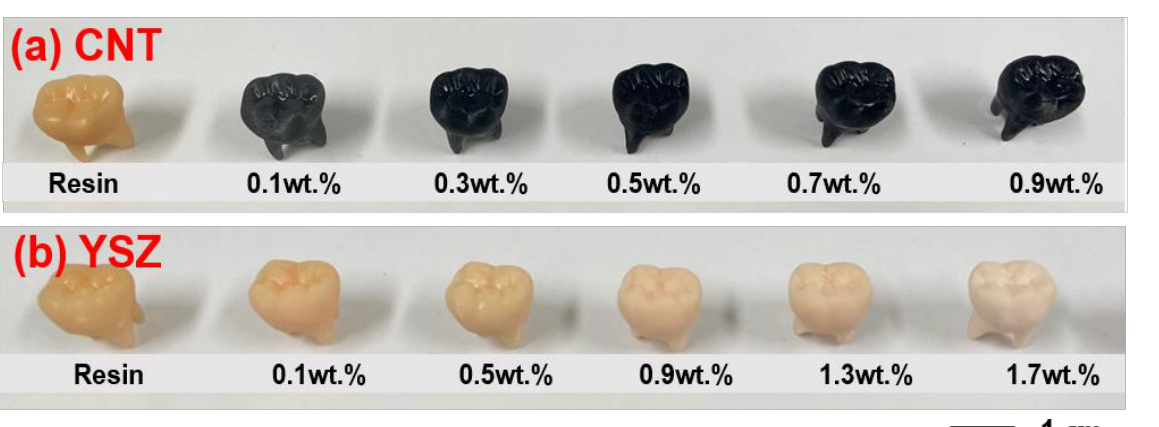
Figure 1. Digital camera images of various ( a ) CNT- and ( b ) YSZ-added 3D-printed teeth with dimensions of 10 × 10 × 10 mm 3 . With increasing CNT and YSZ contents, the teeth become darker and brighter, respectively.